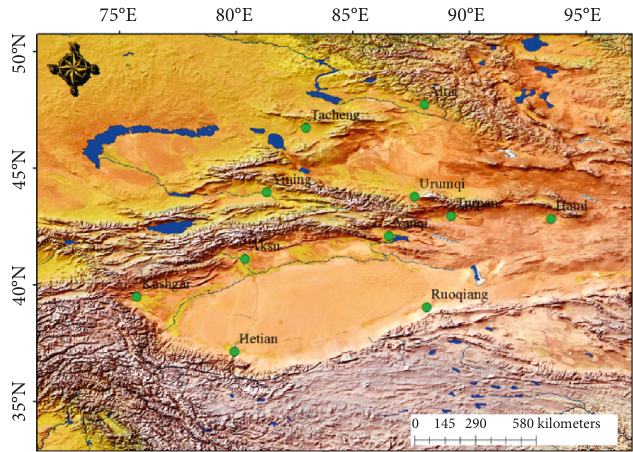
Figure 1: Study area and stations in Xinjiang